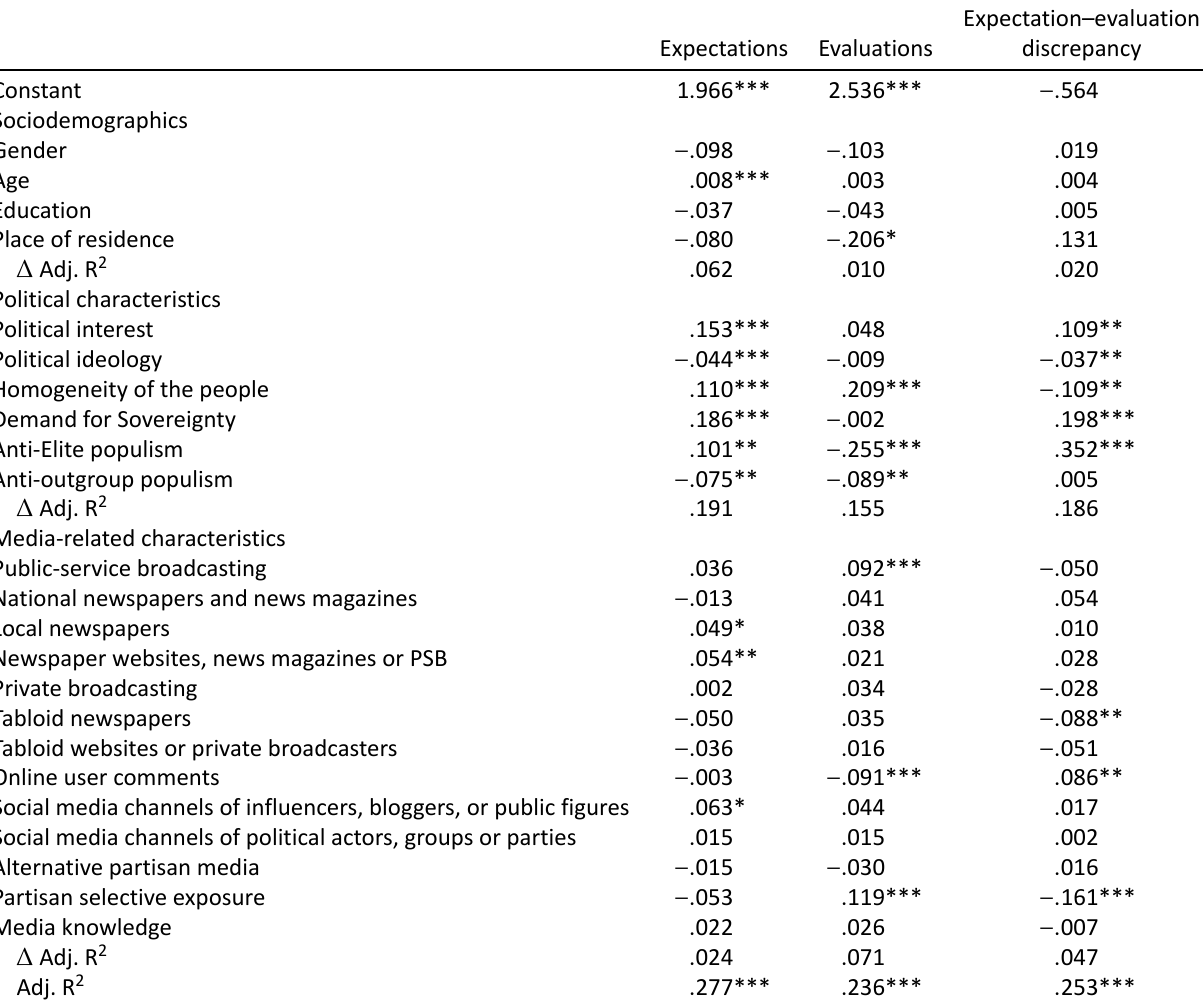
Table 4. Explaining citizens’ expectations, evaluations, and expectation–evaluation discrepancies of media